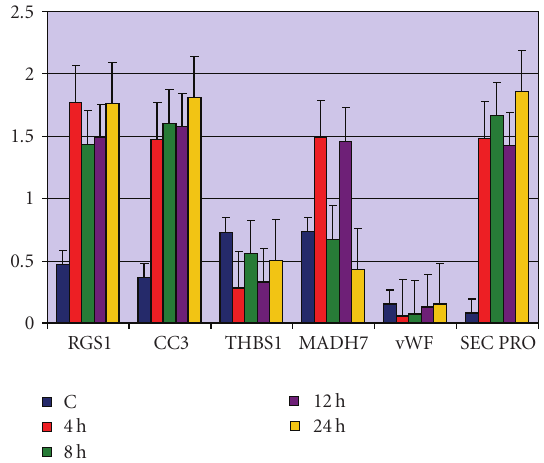
Figure 2: The gene expression in ionizing radiation treated TK6 cells. The expression ratios for various genes at 4, 8, 12, and 24 hours after radiation exposure were determined and compared to the control mock irradiated